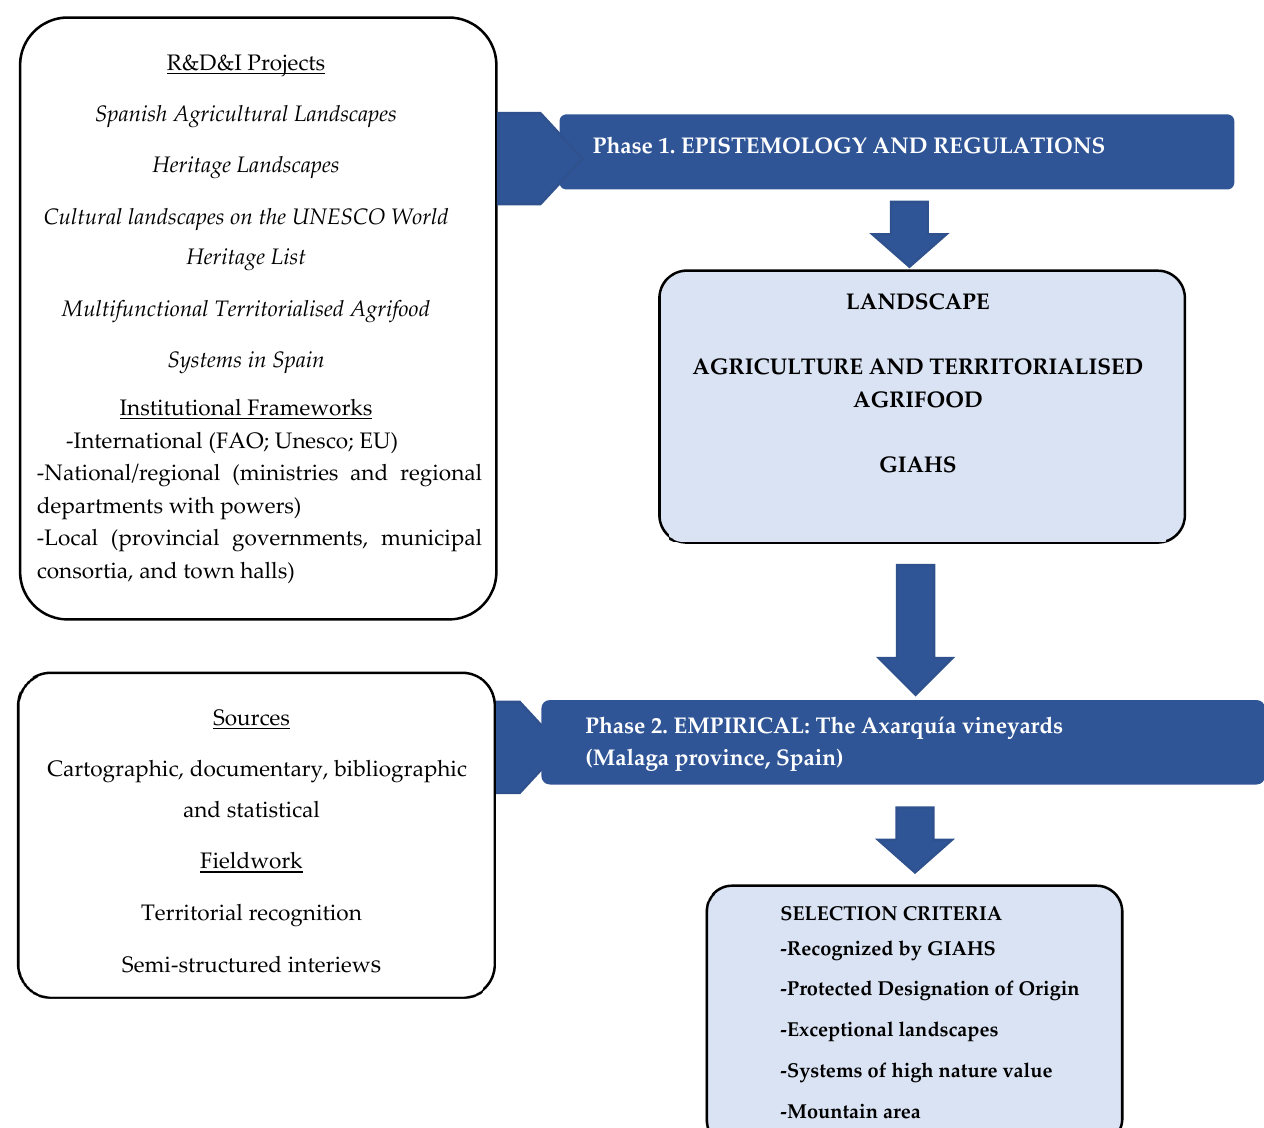
Figure 1. Methodology and research sources. Source: prepared by authors.